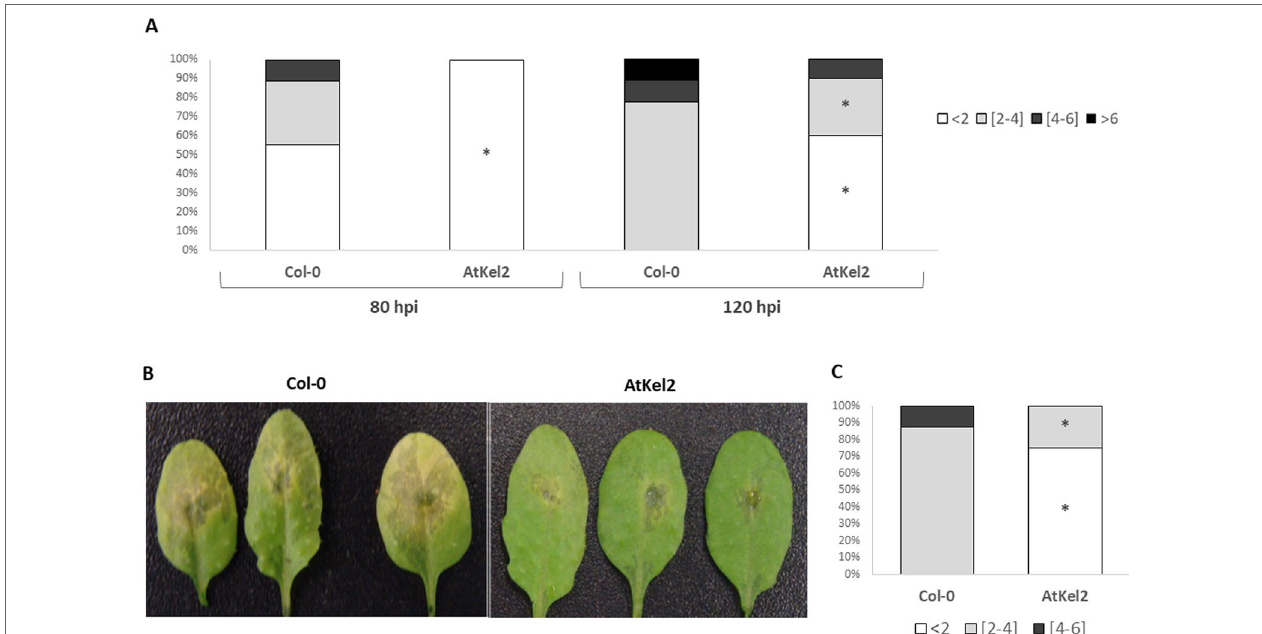
FIgURE 1 | A. thaliana leaf lesions caused by B. cinerea . Leaf bioassay performed on detached leaves of Col-0 and transgenic line AtKel2 at 80 h and 120 h after B. cinerea inoculation (a) . In planta assay performed on Col-0 and transgenic line AtKel2 at 120 h after pathogen inoculation (B and C) . The quantification of the fungal lesions (A in detached leaf assay, and C in planta assay) is represented by columns that show the percentages of the diameter (mm) lesion groups. Data were obtained from three biological replicates with five plants per replicate for each condition. Asterisks denote significant differences at P ≤ 0.05 using the non- parametric Friedman’s test.